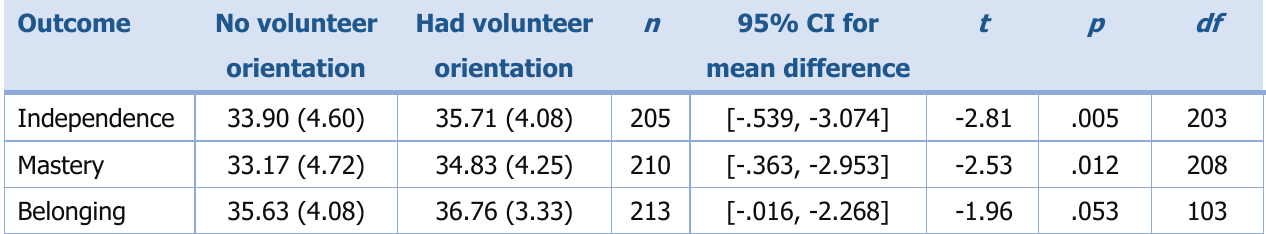
Table 6. Difference of Means Between Training Type and Essential Element Outcome